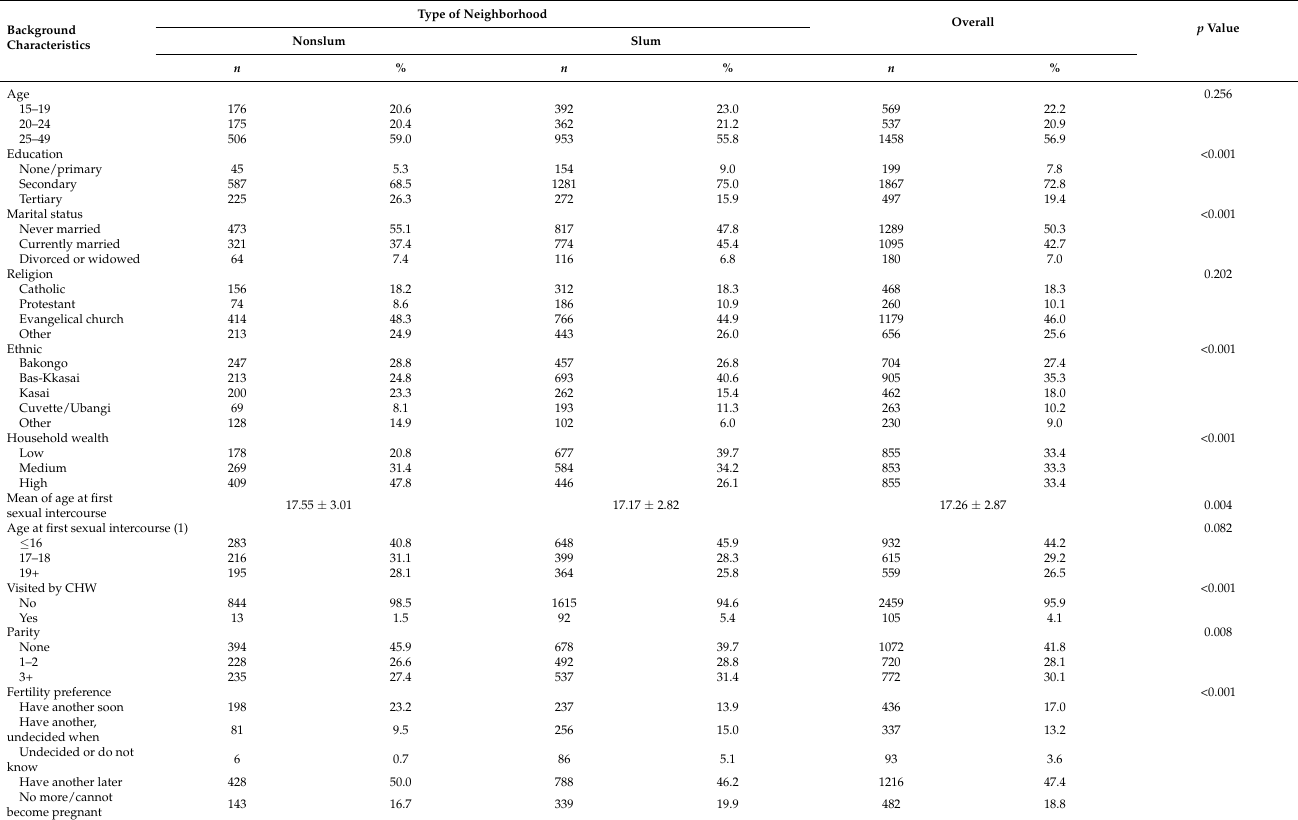
Table 1. Sociodemographic characteristics of women in Kinshasa by type of neighborhood, 2020 (weighted data). Background